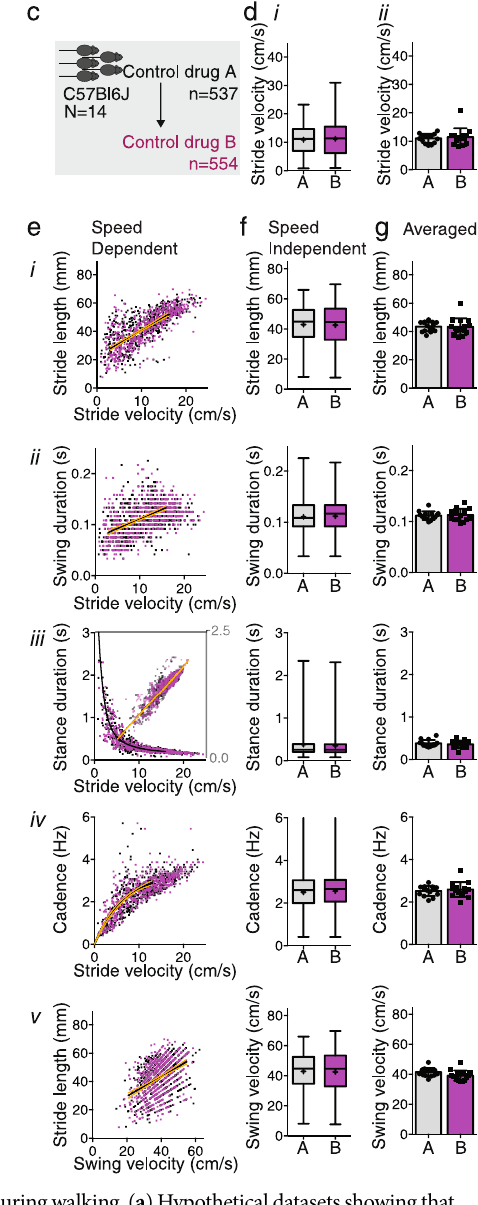
Figure 2. Regression analysis to compare gait datasets during walking. ( a ) Hypothetical datasets showing that regression analysis of stride-to-stride gait data in a velocity dependent manner enables assessment of whether one curve fits both baseline and post-interventional datasets. Changes in gait parameters due to velocity-related changes only do not lead to a shift in regression curve ( i ) whereas changes in gait quality with or without changes in velocity result in a change in slope or Y intercept of the regression curves ( ii ) representing a change in gait signature. Of note, this approach assumes that mice act as their own control or are compared to litter mates. ( b ) Comparison of gait parameters among individual animals within a cohort of C57Bl6/J adult males. i and iv: Whisker plots showing little variation between animals( i and iv ). Ii-iii and v-vi : Data points (each animal depicted by a different color) and regression curves (orange) represent individual animals for the full velocity range ( ii and v) and restricted range ( iii and vi ) as in Supplementary Table S2. Black curves represent the shared regression line. Note that regression lines overlap especially for the restricted range. ( c ) Gait parameters were measured in one cohort under 2 control conditions to validate reproducibility. ( d ) ( i ): Box and whisker plots show the distribution of stride-to-stride velocity (center representing median, center cross representing mean, bars representing minimum and maximum; Mann Whitney Rank test, Supplementary Table S3). ( ii ) bar graphs with scatter plots represent average stride velocity (2-tailed t-test), with error bars indicating standard deviation. ( e ) Relationships of stride length ( i ), swing duration ( ii ), stance duration ( iii ), and cadence ( iv ) as a function of stride velocity, and of stride length as a function of swing velocity ( v ) were captured with non-linear regression models (Supplementary Table S2). The fit of one curve to both data sets was compared with the fit of individual curves fit to each dataset (Supplementary Table S3). Orange lines represent 95% confidence intervals. ( f ) ( i-v ) and g ( i-v ): Stride-to-stride data represented as whisker plots (Mann Whitney Rank test, Supplementary Table S3; bars indicate maximum and minimum) and bar graphs with scatter plots represent averaged data (paired 2-tailed t-test, Supplementary Table S3; error bars indicate standard